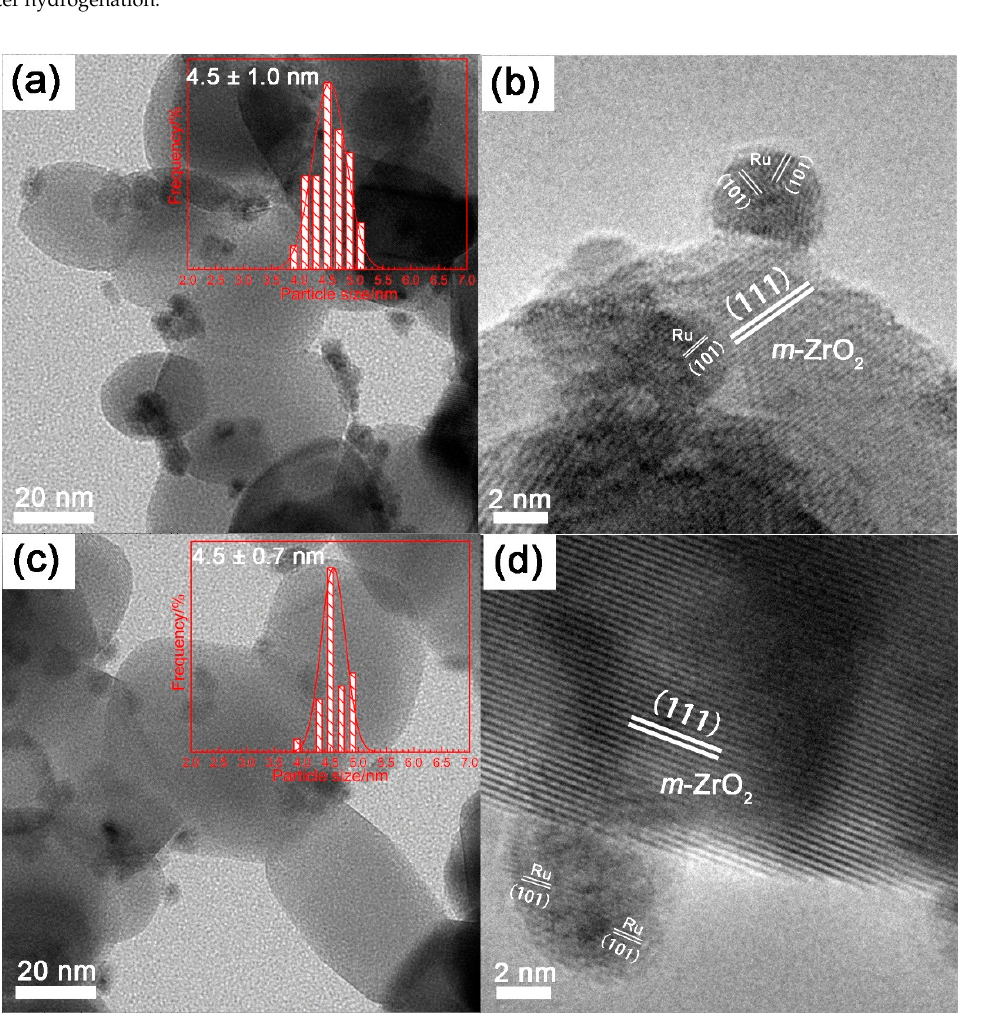
Figure 2. TEM images and the Ru particle size distribution of Ru-Zn (0.60)/m-ZrO 2 catalysts before ( a , b ) and after ( c , d ) catalytic experiments.